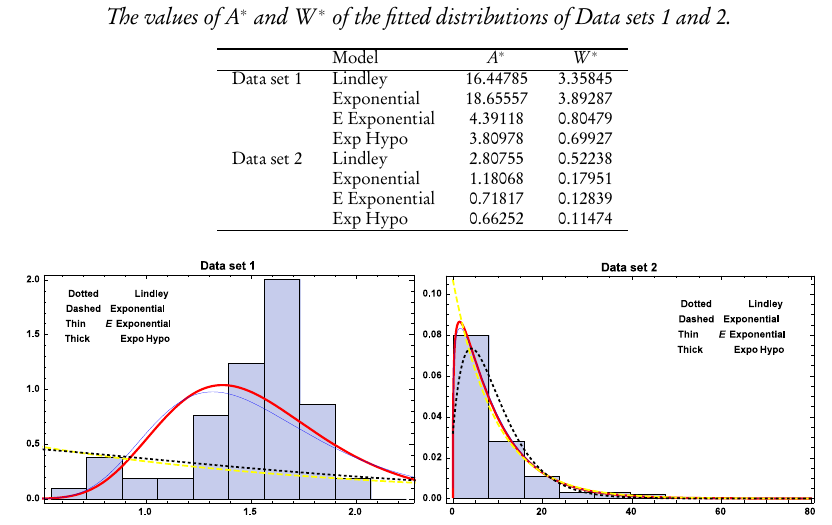
Figure 4 – The fitted densities superimposed on the histogram of Data sets 1 and